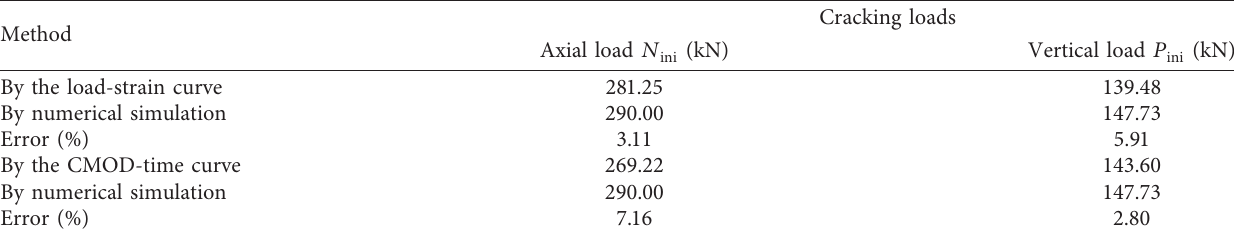
Table 2: Comparison of the cracking loads between numerical and experimental